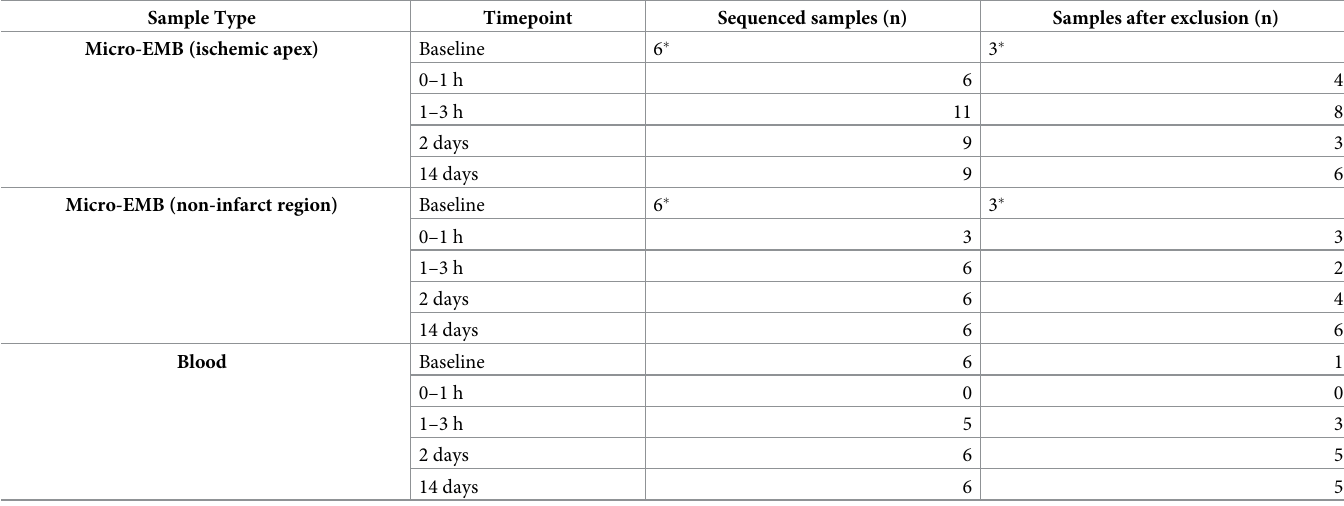
Table 1. Number of samples from each timepoint, before and after